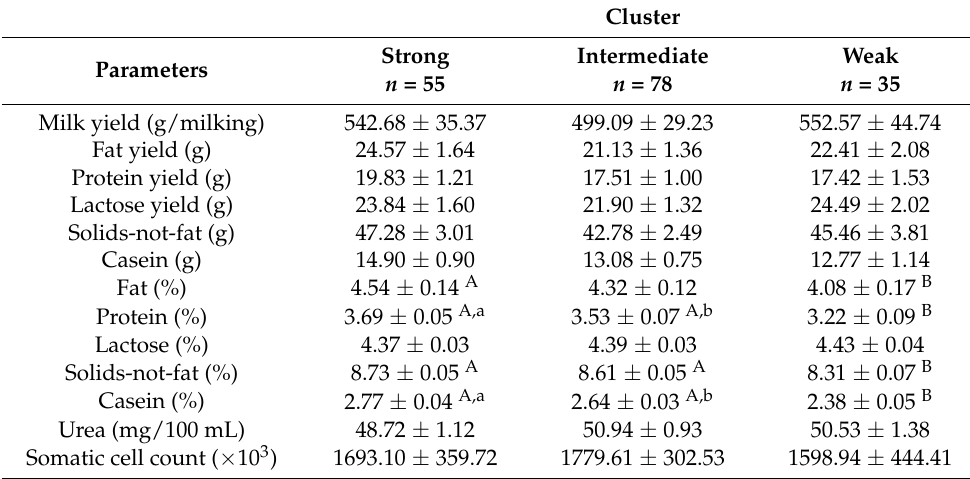
Table 3. Effect of genotypes at the CSN1S1 locus clustered as strong, intermediate, and weak on the milk yield and composition of all the animals